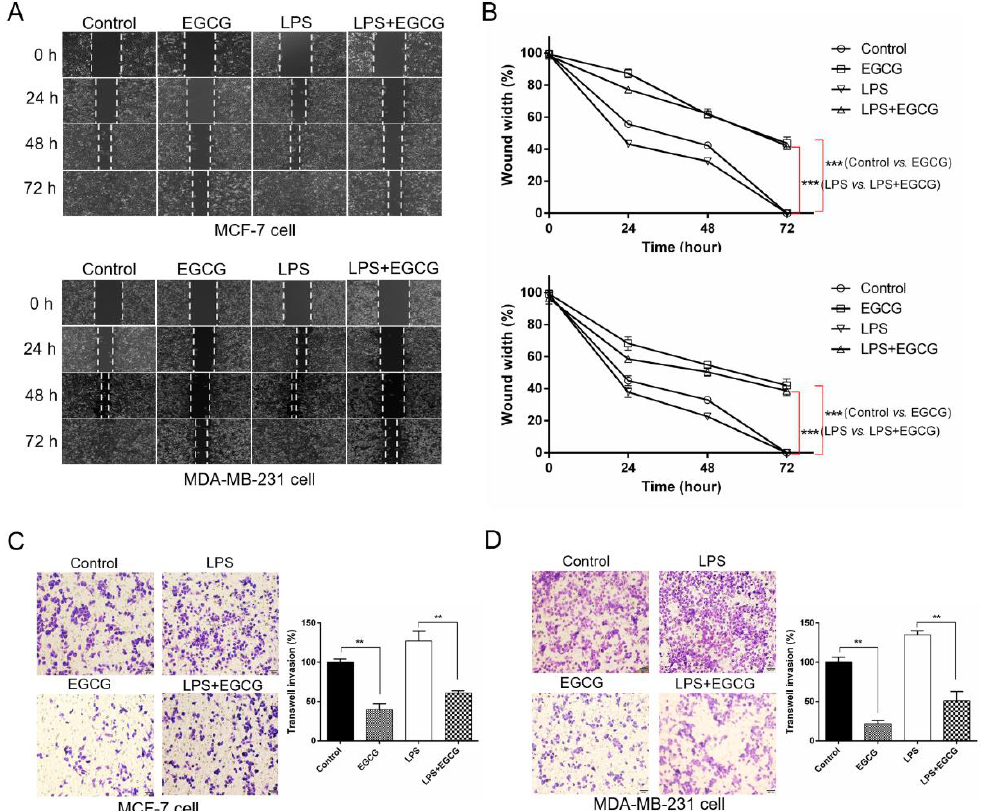
Figure 2. EGCG suppresses the migration and invasion of breast cancer cells. ( A ) Wound healing assay of MCF-7 (upper panel) and MDA-MB-231 (lower panel) cells treated with EGCG (20 µ M), LPS (1 µ g / mL), and combined EGCG (20 µ M) and LPS (1 µ g / mL). Images were taken before (0 h) and after wound closure (24, 48, and 72 h). ( B ) The data are shown as the percentage of the unhealed width by normalizing the width of the initial wound at 0 h (set to 100%). The significant di ff erences were determined by the one-way ANOVA for area under the curve of each treatment (one-way ANOVA; *** p < 0.001 control vs. EGCG, *** p < 0.001 LPS vs. LPS + EGCG) ( n = 3). MCF-7 cells ( C ) were treated as in ( A ) for 12 h and MDA-MB-231 cells ( D ) were treated as in ( A ) for 16 h, and then assayed for invasiveness. Columns in the graph ( C , D ) represented the analysis of the invasive cell count (one-way ANOVA; ** p < 0.01 control vs. EGCG, ** p < 0.01 LPS vs. LPS + EGCG). Scale bars, 50 µ m. Data are shown as mean ± SEM from three independent experiments.